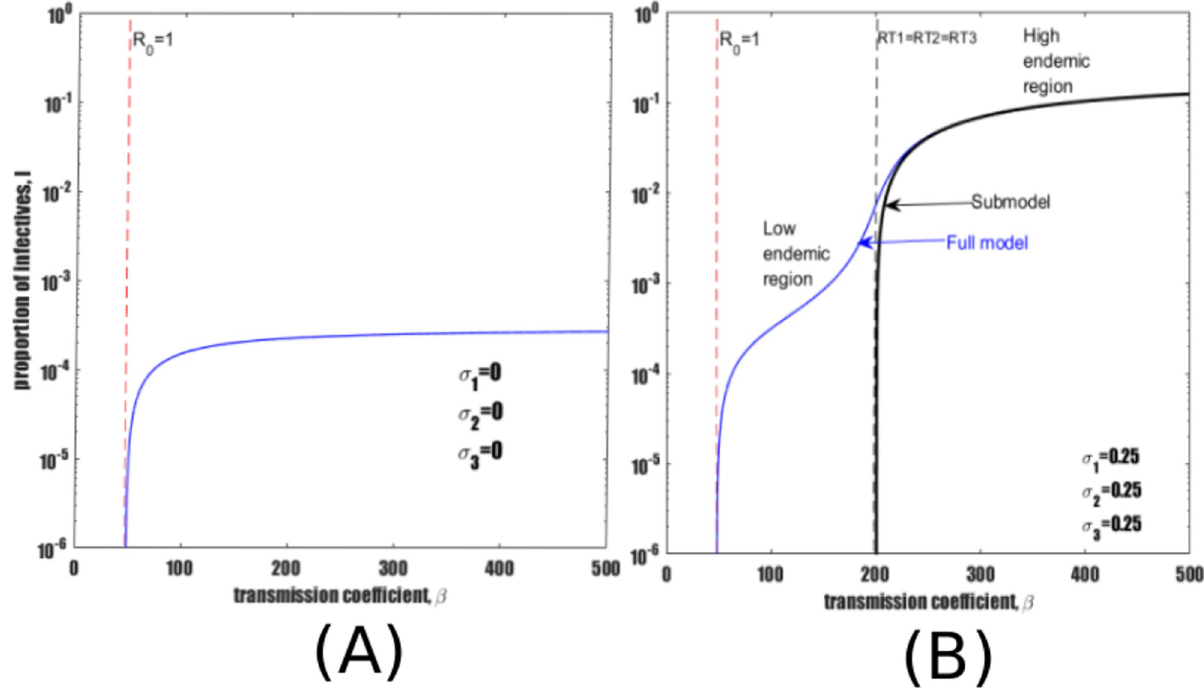
Fig 2. Bifurcation diagram of equilibrium TB prevalence I � as a function of β . (A) In the absence of reinfection the epidemic threshold occurs at R 0 = 1. (B) Bifurcation diagrams of the full model equilibria (See S3 Appendix) and reinfection submodel (3) equilibria superimposed on the same axes. In both figures the red dotted vertical line marks the bifurcation point R 0 = 1. Black vertical dashed line marks the point where reinfection thresholds RT1, RT2 and RT3 converge. Parameters as in Table 1. In both panels semi-logarithmic scale is used for clarity.